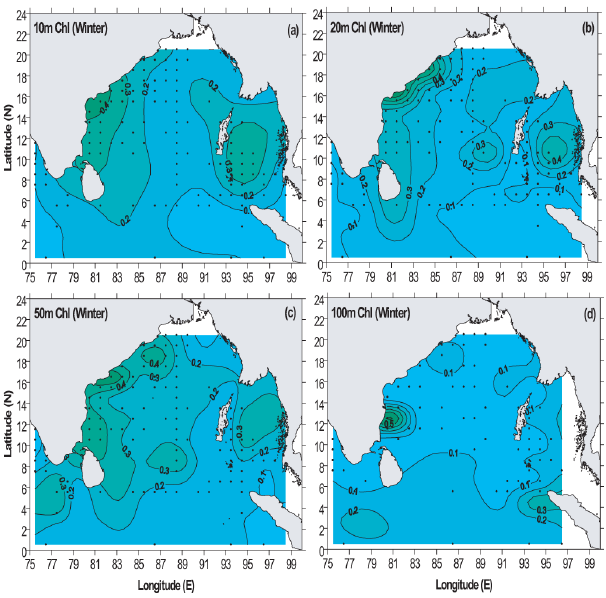
Figure 13. Spatial distribution of chlorophyll a (mgm − 3 ) at (a) 10, (b) 20, (c) 50, and (d) 100m during summer monsoon. Note the change in contour interval in (b) .